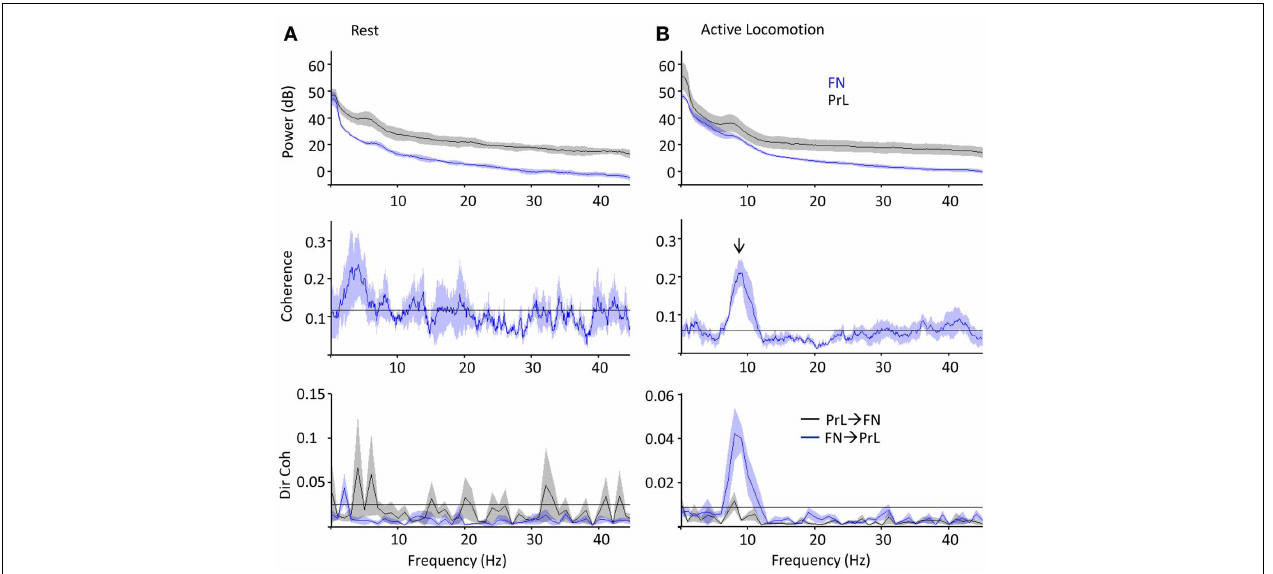
FIGURE 5 | PrL-FN LFP network activity during rest and open field exploration. Grouped power spectra (top panel; cerebellum/FN in blue, prelimbic cortex/PrL in black), coherence (middle panel) and directed coherence (Dir coh, bottom panel; FN-PrL direction in blue, PrL-FN in black) as rats sat quietly on rest platform ( A , n = 5) or actively moved